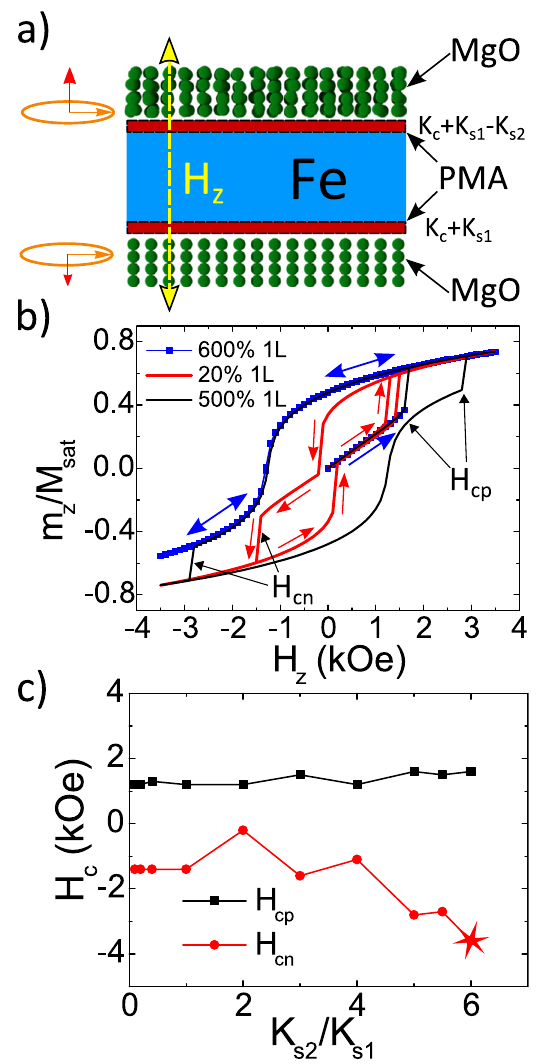
Figure 6. The left side of part ( a ) explains the presence of the net Rashba field component perpendicular to the interface as a consequence of the difference in the upper vs. bottom longitudinal electric field components. This is due to the different degree of disorder at the interfaces. The right part in ( a ) explains an alternative possibility for the appearance of the second order surface anisotropy at the more disordered (top) interface. Part ( b ) shows two simulated magnetization loops (within model M 2 i ) with different relations between the second order and the interfacial anisotropy terms. The coloured arrows (related to the blue and red cycles respectively) show the magnetic cycle step by step sweep. Part ( c ) shows how the asymmetry of the positive ( H cp ) and negative ( H cn ) coercive fields, corresponding to the transition between the near in-plane and near out of plane magnetizations, emerges with the increase of the relative contribution of the second order anisotropy at the Fe/MgO interface. The point marked as a star shows a negative coercive field out of the actual field